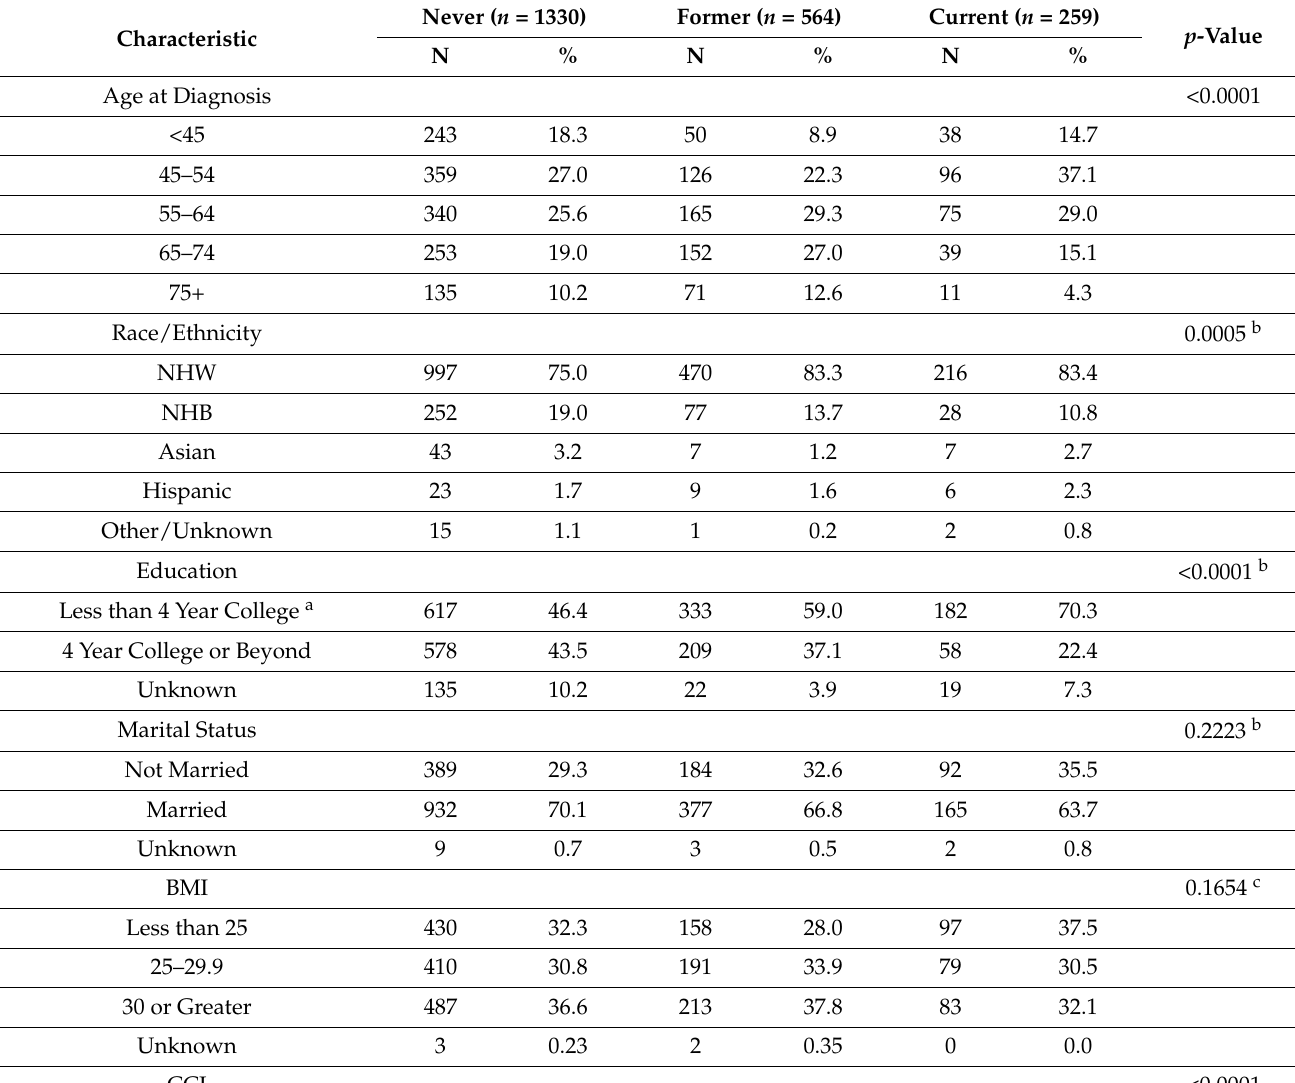
Table 1. Demographic characteristics of 2153 women with breast cancer enrolled in the